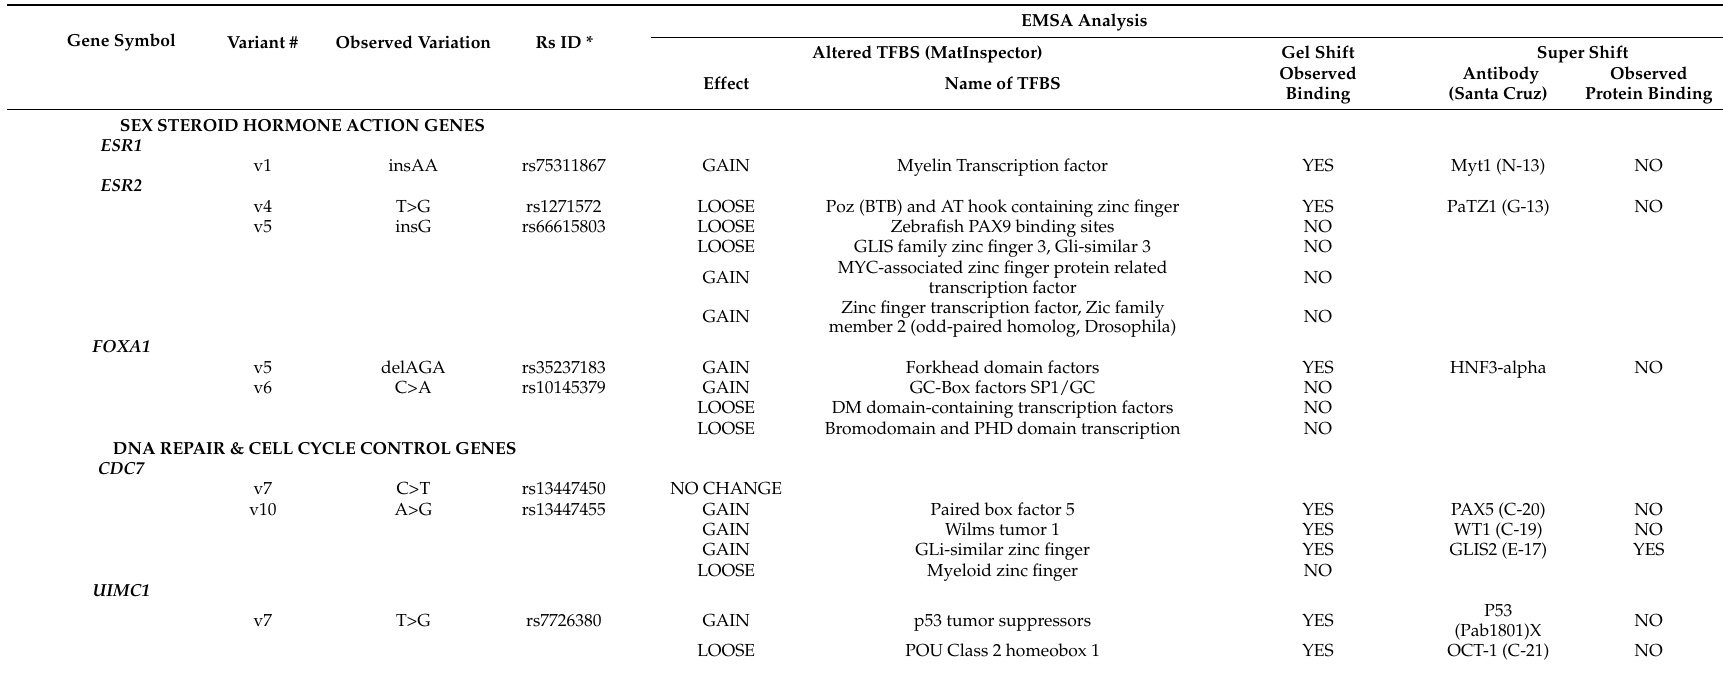
Table 2. Altered transcription factor binding sites and corresponding antibodies tested in Electrophoretic Mobility Shift